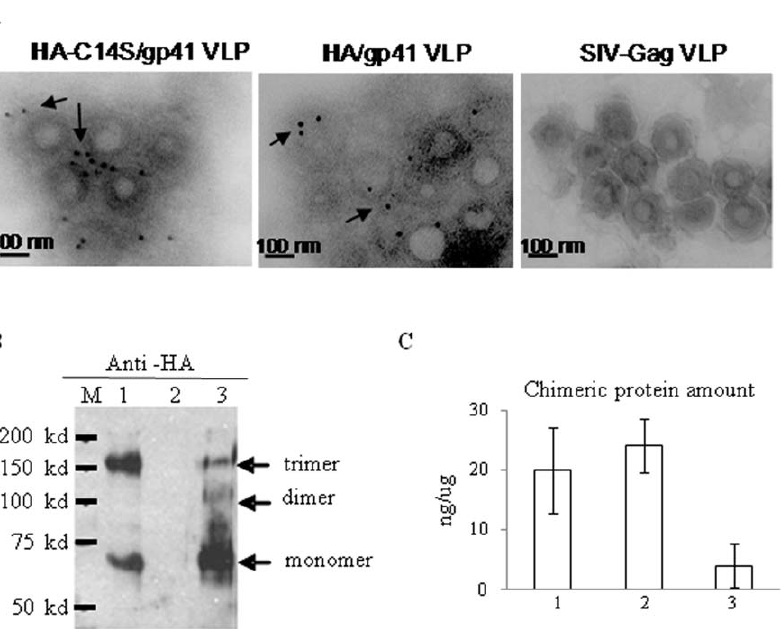
Figure 2. Characterization of the HA/gp41 and HA-C14S/gp41 VLPs. VLPs were produced in Sf9 insect cells using the recombinant baculovirus expression system and purified through a sucrose gradient as described in Materials and Methods. A. Characterization of VLPs by immune-gold-particle labeling and electron microscopy. Purified HA/gp41, HA-C14S/gp41, as well as the control SIV-Gag VLPs were coated onto a sample grid and then incubated with rabbit-anti-HA antibody Jose4 followed by incubation with gold-particle-conjugated goat-anti-rabbit secondary antibodies. The samples were then fixed with 1% uranyl acetate and then examined under an electron microscope. Arrows indicate gold-particle- labeled glycoproteins on the surface of VLPs. B. Detection of HA/gp41 and HA-C14S/gp41 chimeric protein oligomers in VLPs by Western blot. VLPs were lysed with 1% Triton X-100 and then mixed with non-reducing protein sample buffer followed by analysis by SDS-PAGE coupled with Western blot using antibodies against HA (Jose4). Lane M, molecular weight marker; 1, HA-C14S/gp41 VLP, 2, control SIV Gag VLP; 3, HA/gp41 VLP. C. Determining the amount of HA/gp41 and HA-C14S/gp41 chimeric proteins in VLPs by ELISA. VLPs were lysed with 1% Triton X-100 and then coated onto a microtiter plate at 1 m g per well, and the amount of chimeric proteins were detected by ELISA using rabbit-anti-HA antibody Jose4. Control wells were coated with 1 m g of SIV-Gag VLPs. A standard curve was constructed by coating the wells with serial dilutions of purified HA-histag proteins in mixture with 1 m g SIV Gag VLPs and was used for calculating the amount of chimeric proteins in